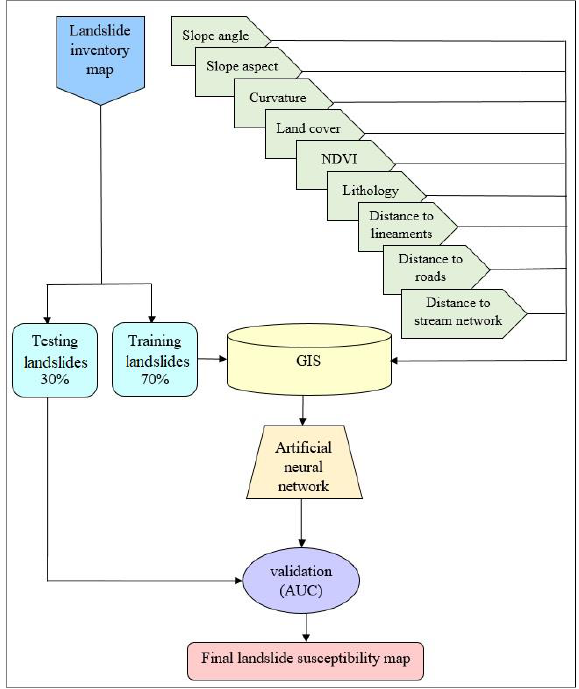
Figure 3. Methodology of landslide susceptibility